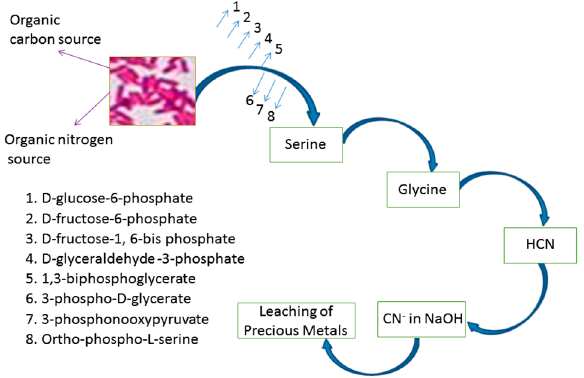
Figure 6. The production route of cyanide by microorganism with the subsequent use in cyanidation of precious metals (arrows are denoting the metabolic pathway of Chromobacterium violaceum ).